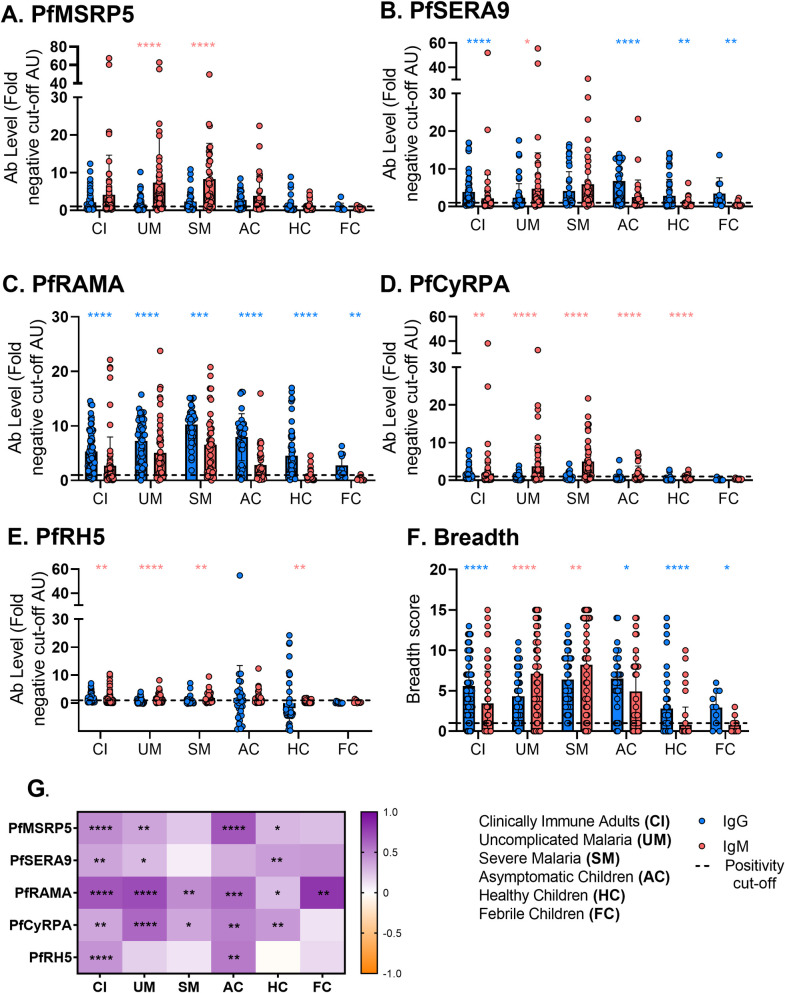
Comparison of levels and correlation of IgG and IgM to P. falciparum merozoite antigens per clinical group.Levels (fold over cut-off AU, mean with SD) of IgG (blue) and IgM (red) specific for PfMSRP5 (A.), PfSERA9 (B.), PfRAMA (C.), PfCyRPA (D.) and PfRH5 (E.) were measured in clinically immune adults (CI), asymptomatic children (AC), healthy children (HC), febrile children (FC) and children with uncomplicated (UM) and severe malaria (SM). Statistical significance (Wilcoxon test) between IgG and IgM is represented by asterisks (p<0.05 (*), p<0.01 (**), p<0.001 (***), p<0.0001 (****)). Asterisk colors represent whether IgG (blue) or IgM (red) is significantly higher. Exact p values are shown in S2 Table in S1 File (levels) and S3 Table in S1 File (prevalence). Spearman’s correlation of IgM and IgG responses for each antigen and clinical category is shown in the heat map (G). Statistical significance is represented by asterisks and color represents the strength and direction of correlation as shown in the key.